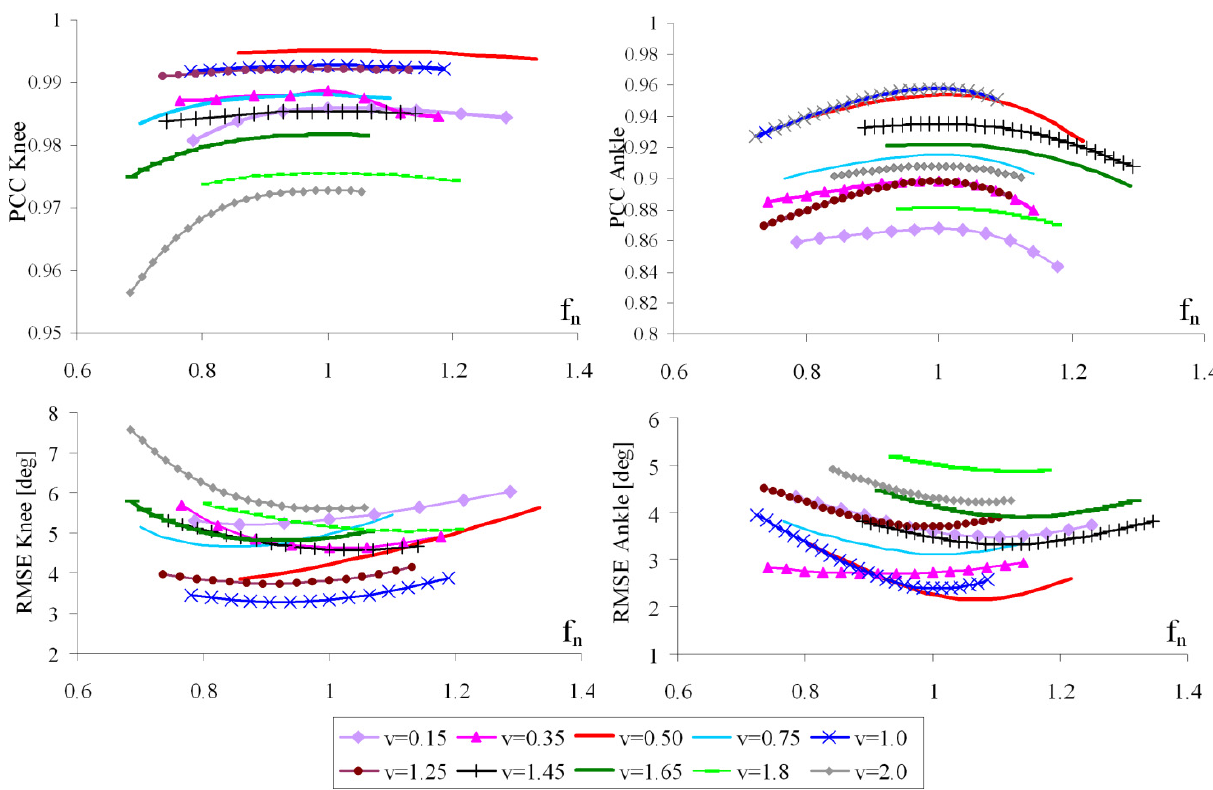
Figure 8 . Pearson’s correlation coefficient (PCC) and RMSE between goniometers and estimated angles, for knee and ankle angles, vs. filtering frequency in the range [ f /3, f /2]. The normalization is with respect to the optimal frequency. Each curve gc gc corresponds to different gait velocity (in